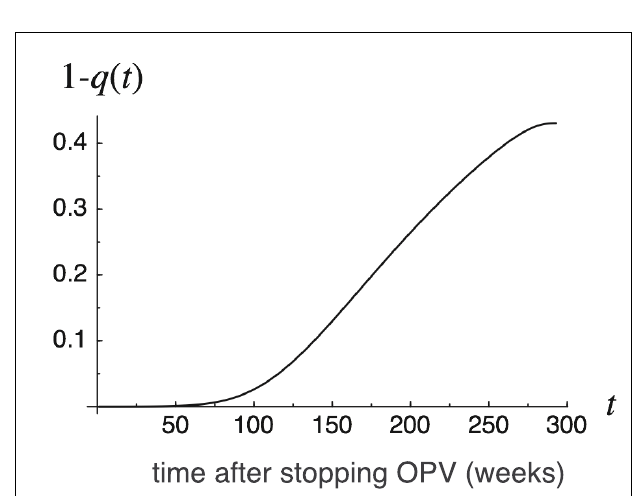
FIGURE 7 | Marginal risk 1 − q ( t ) of outbreaks as a function of time t since OPV cessation. The marginal risk 1 − q ( t ) is defined as the probability that an infected host present at time t harbors viruses whose progeny will cause outbreaks in the future. p = 0.7, β = 3.7, γ = 0.18, u = 0.00025, K = 10 8